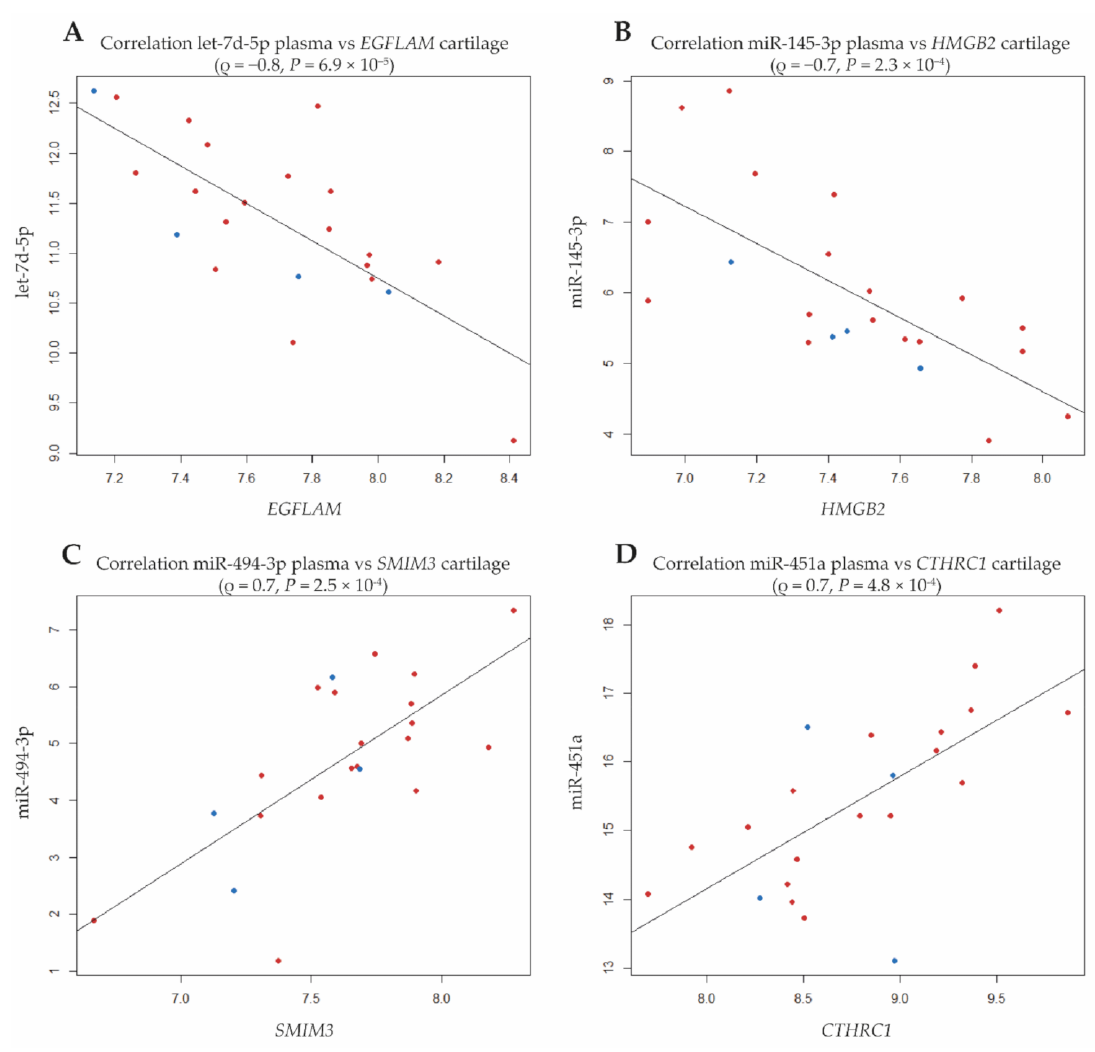
Figure 3. Dot plots of strongest correlations between the 4 cartilage genes strongly correlating to levels of at least 10 different plasma miRNAs (pointed out in Figure 2: ( A ): EGFLAM ; ( B ): HGMB2 ; ( C ): SMIM3 ; ( D ): CTHRC1 ; red dots refer to female and blue dots to male samples). Table 2. ( A ) Unique genes showing strong correlation with plasma miRNAs ( ρ ≥ |0.7|, P < 6.9 × 10 − 5 ). Additional miRNAs with ρ ≥ |0.6| and direction of differentially expressed genes (DEG; preserved OA cartilage versus healthy cartilage) are shown. ( B ) Correlations (left) and matrix (right) of genes strongly correlating to at least 10 plasma miRNAs (indicated in bold in ( A